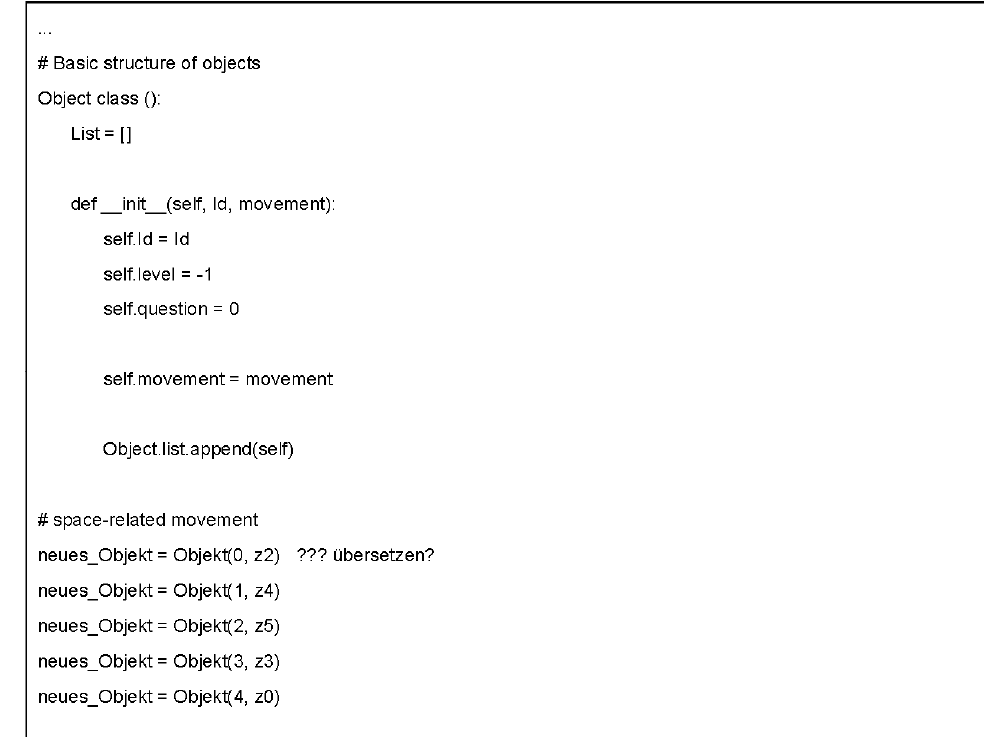
Figure 7. Script of spatial model of cultural meaning. For starting the script at the beginning of the experiment, only one class and five empty instances were predefined.